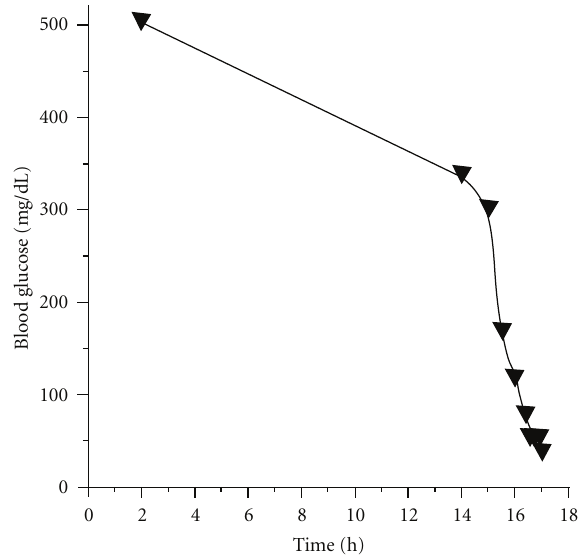
Figure 2: The result of the fasting test. Blood glucose levels were monitored. After 17 h of fasting, the blood glucose level decreased to